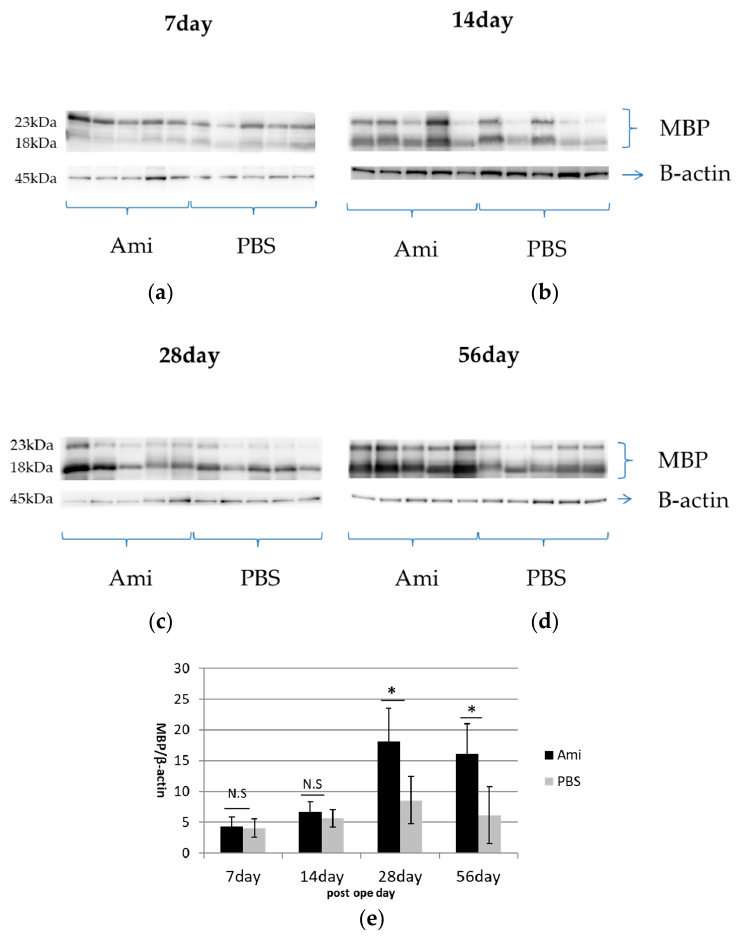
Figure 5. ( a – e ) Western blotting was performed using anti- myelin basic protein (MBP) (18, 23 kDa) and anti-b actin (45 kDa) antibodies. At days 28 and 56 after injury, MBP expression was significantly higher in the amiloride group compared to the PBS group. Asterisks indicate significant difference between the amiloride and PBS groups with a Mann–Whitney U test (* p < 0.05, n = 5 per group, error bars are standard